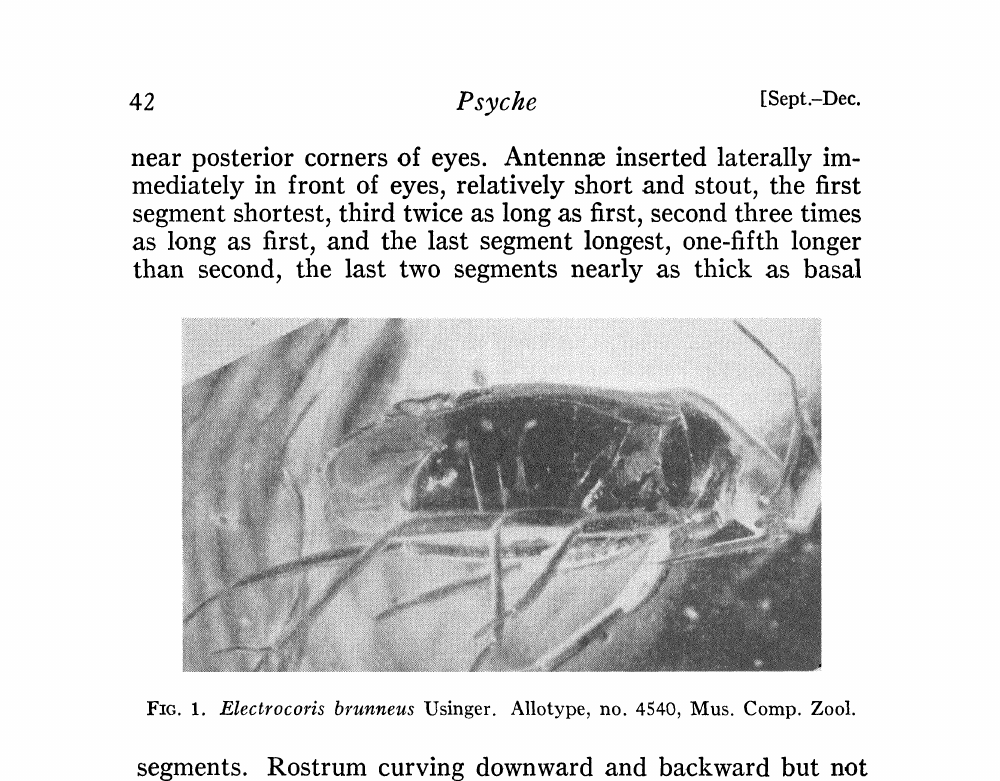
FIG. 1. Electrocoris brunneus Usinger. Allotype, no. 4540, Mus. Comp.